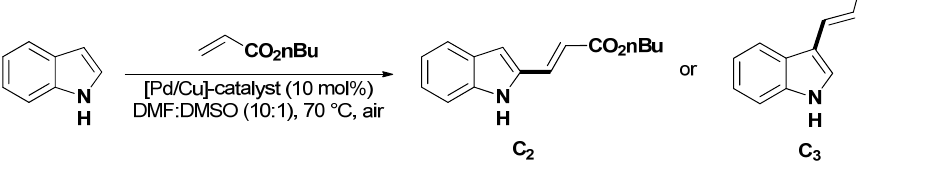
-alkenylation of indole. 3